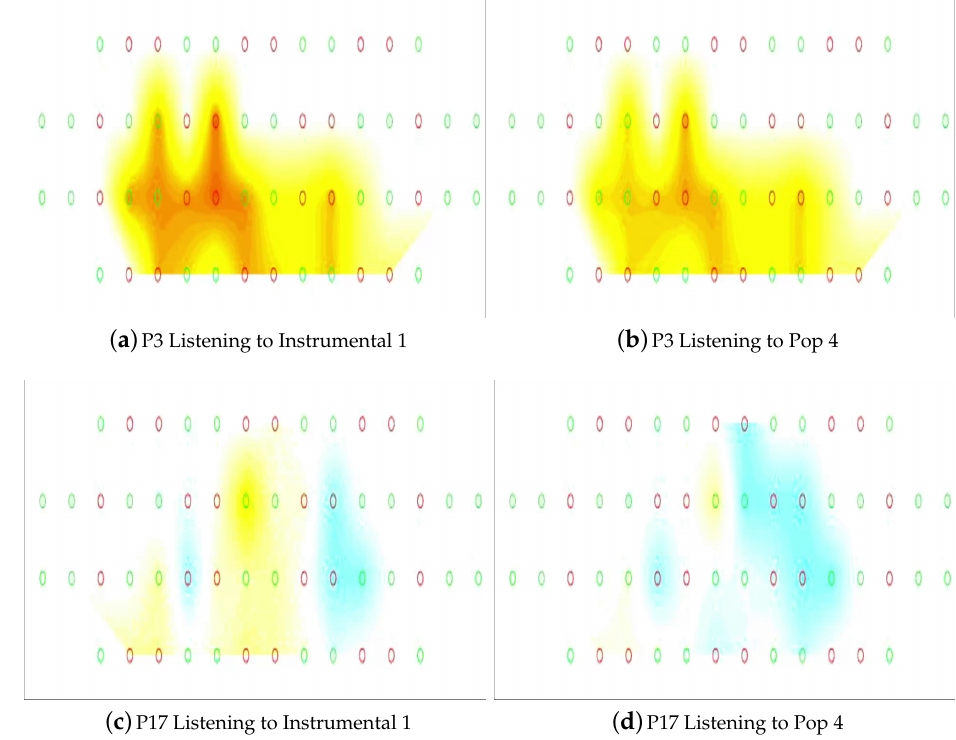
Figure 9. Sample Activation Map Frames: ( a , b ) = Frame 417 of P3 Listening to Instrumental 1 and Pop 4; ( c , d ) = Frame 417 of P17 Listening to Instrumental 1 and Pop